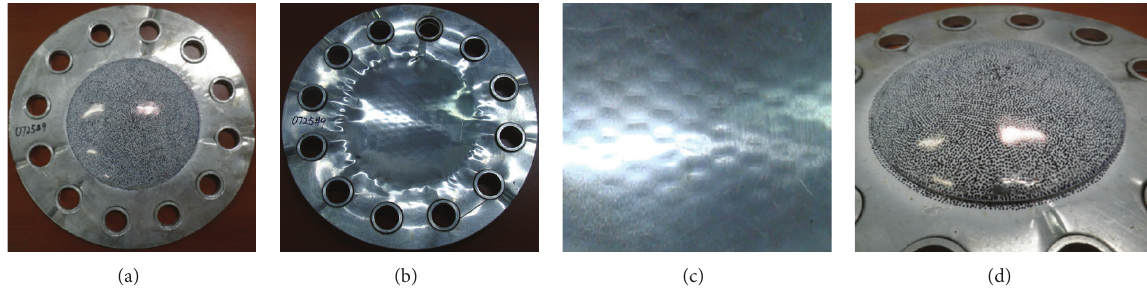
̂𝐼 = 1.094 : (a) and (b) show the dry and the wet face sheets; (c) shows a side